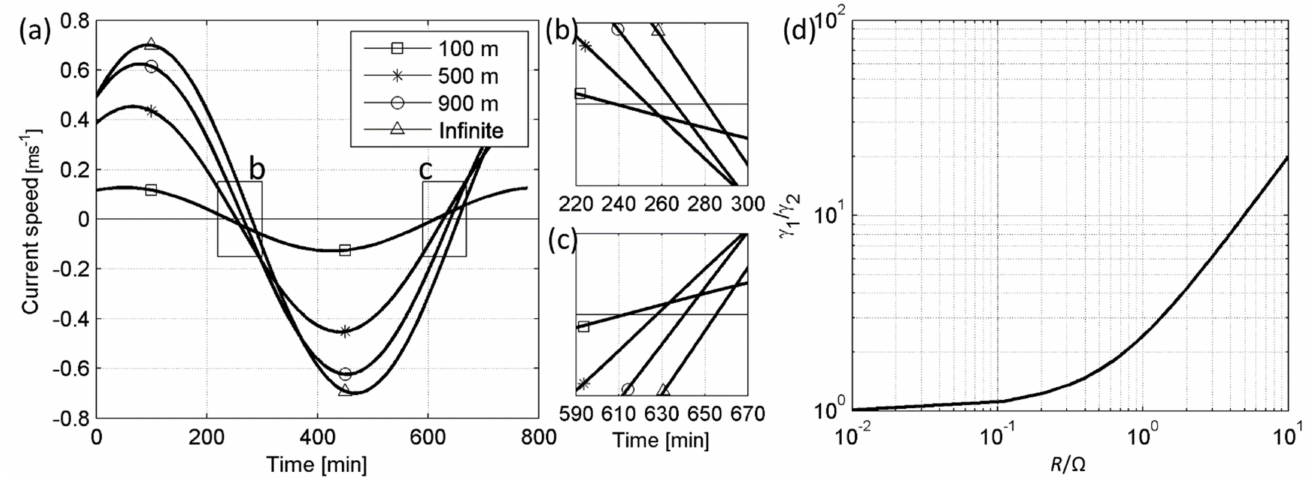
Figure 7. ( a ) Time series of alongshore current at different offshore distances predicted by the proposed CBL model, given R / Ω = 1 and υ = 50 m 2 s − 1 . ( b ) and ( c ) are enlarged views of the rectangles in ( a ) to show the leading phase of nearshore current. ( d ) shows the relationship between R / Ω and γ 1 / γ 2 . If R approaches zero, the CBL becomes the solution of the Stokes boundary layer, in which only the eddy viscosity coefficient is